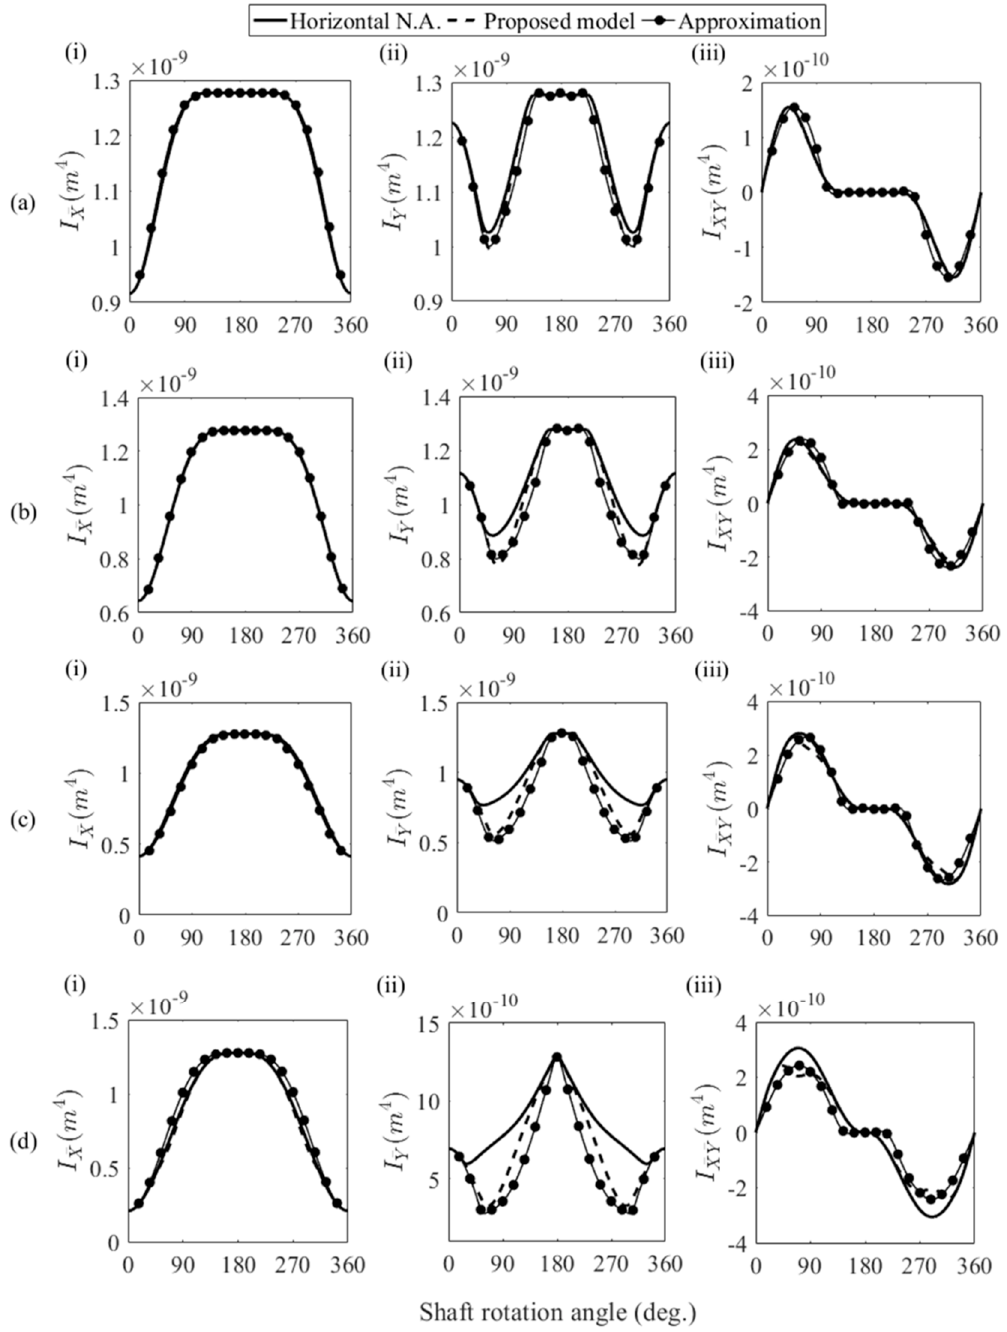
Figure 11. Area moment of inertia of the total non-cracked area about the ( i ) X axis and ( ii ) Y axis, and the ( iii ) product moment of area for crack depths of ( a ) µ = 0.3, ( b ) µ = 0.5, ( c ) µ = 0.7 and ( d ) µ = 1.0. R = 6.35 mm.